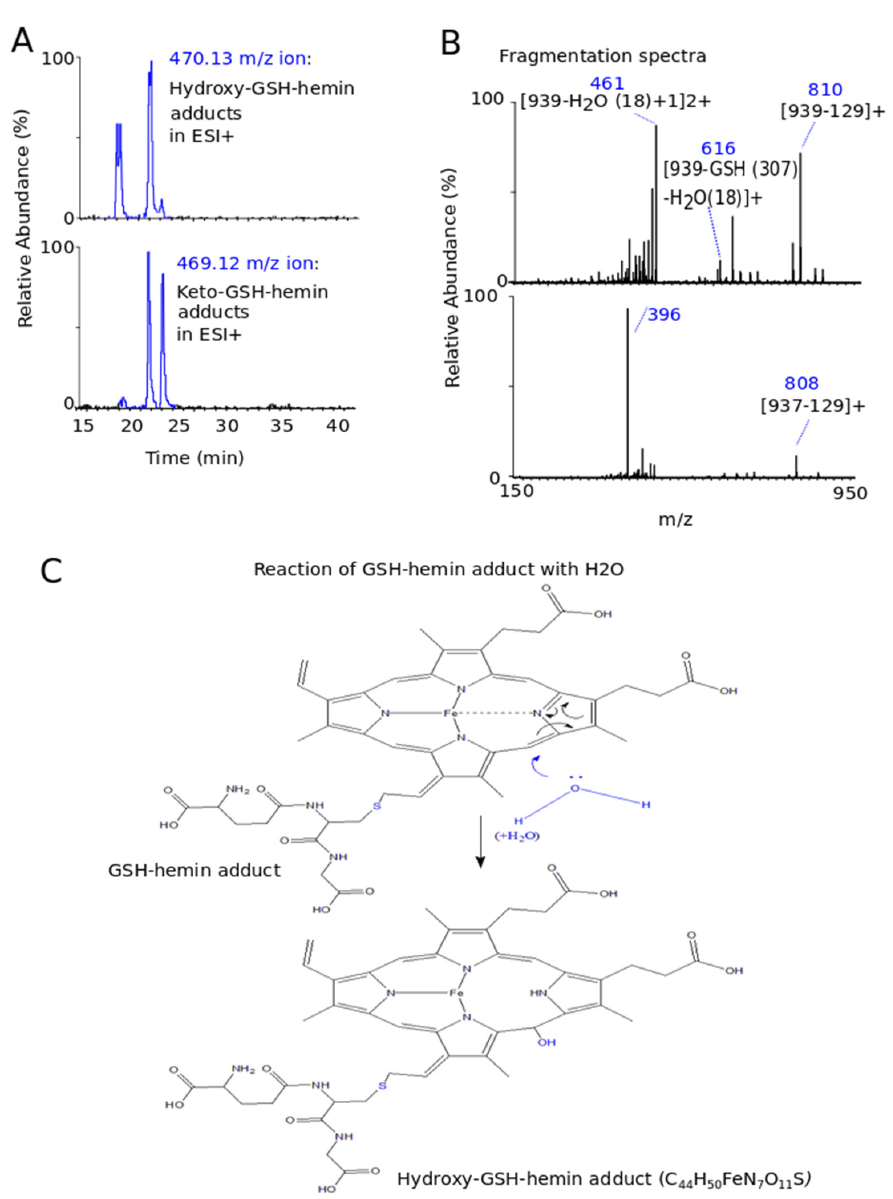
Figure 6. Formation of hydroxy–GSH–hemin adducts at the in vitro reaction between GSH and hemin. The ion chromatographs ( A ) and fragmentation spectra ( B ) of the 470.13 m / z and 469.12 m / z ions, corresponding to the [(M+H-H2)+H] 2+ of hydroxy–GSH–hemin adducts and keto–GSH–hemin adducts, respectively. ( C ) The mechanism of reaction of GSH–hemin adducts with water and the resulting structure of the hydroxy–GSH–hemin adducts (one isomer) is